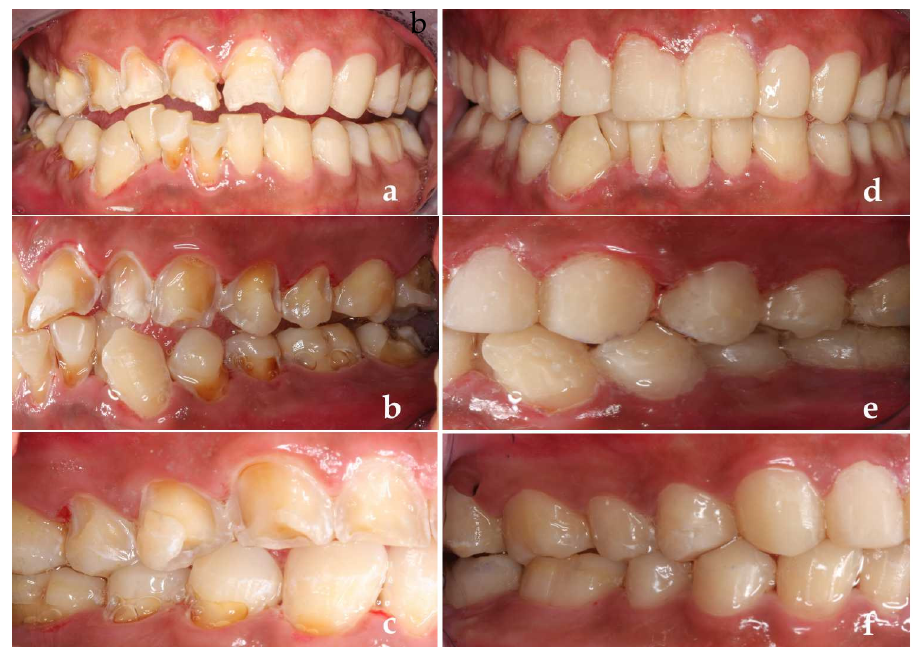
Figure 4. ( a – c ) During the first treatment; ( d – f ) First treatment completed.